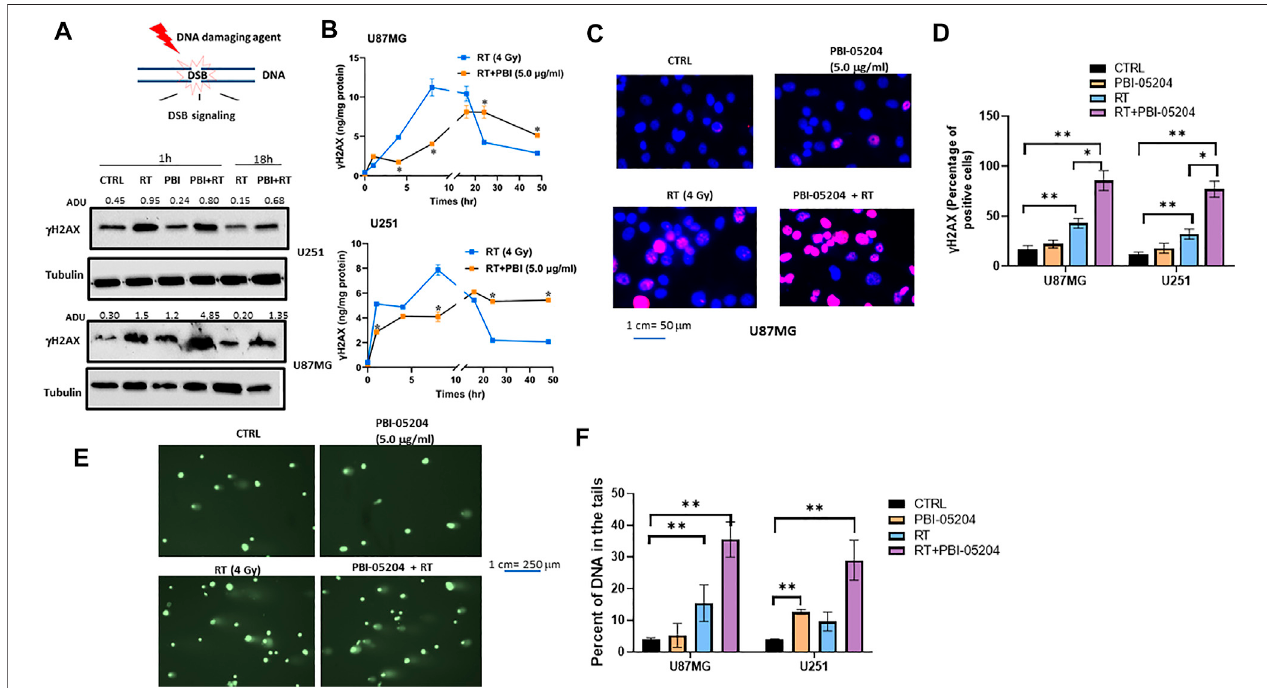
FIGURE4| PBI-05204 augmented RTmediatedDNAdamage inU87and U251cells. (A) .RepresentativeWesternblots performed ontotalcellextractscollected fromU87MGandU251cellstreatedwithRT(4 Gy),PBI-05204(2.5 μ g/ml)oracombinationofRTandPBI-05204for1and18 h. γ H2Axbandswereanalyzedbyimage J software and adjusted densitometric Unit values (ADU) were normalized vs α -tubulin which were presented on the top of γ H2Ax bands. (B) Time course ELISA detectionfor γ H2AxinU87MGandU251cellstreatedwithRT(4 Gy),PBI-05204(5.0 μ g/ml)orcombinationsfor1 – 48 h.Dataarepresentedasmean±SD( n =5). * p < 0.01RTvsRT+PBI-05204. (C) RepresentativeImmuno fl uorescenceimagesfor γ H2AxnuclearfociinU87MG cells. (D) Percentageof γ H2Axpositivecells(de fi ned ascellswithatleast fi ve γ H2Ax focieach)inatleast100nuclei( n =3)in1 h-treatedU87MGand U251celllines.Dataarepresented asmean±SD.* p < 0.05, ** p < 0.01. (E) representativeimagesof Comet assay in U87MG cells treated for 1 h with RT (4 Gy), PBI-05204 (5.0 μ g/ml) or acombination ofRT and PBI-05204. (F) . Percentage of DNA in the tails of U87MG and U251 cells after they were treated with RT, PBI-05204 and RT + PBI-05204 from Comet Assay ( n = 3). Data are presented as mean ± SD. ** p <